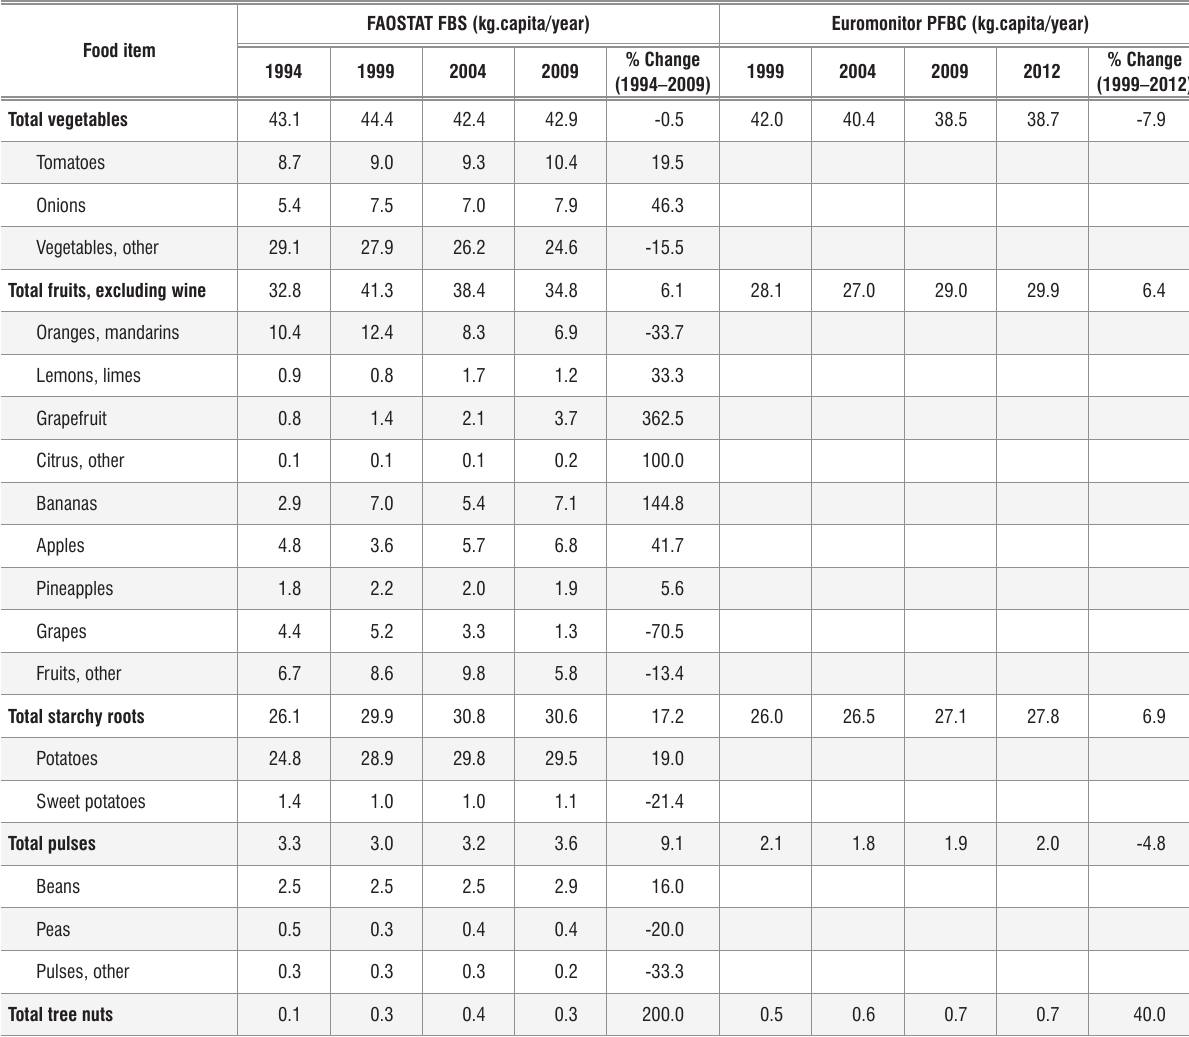
Comparison of total vegetable, fruit, starchy root, pulses and tree nut consumption in South Africa assessed by FAOSTAT food balance sheets (FBS) and Euromonitor Packaged Food and Beverage Consumption